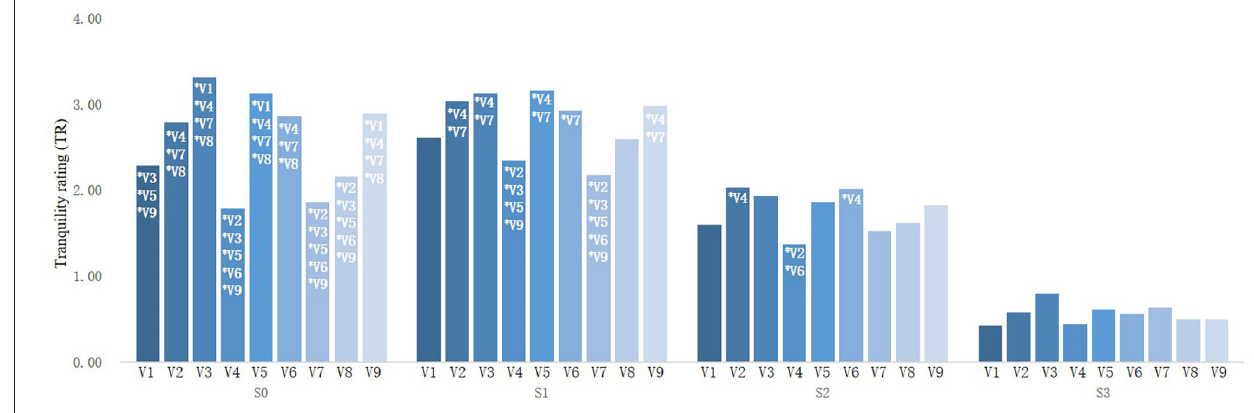
FIGURE 6 | Comparison of different types of street TR.